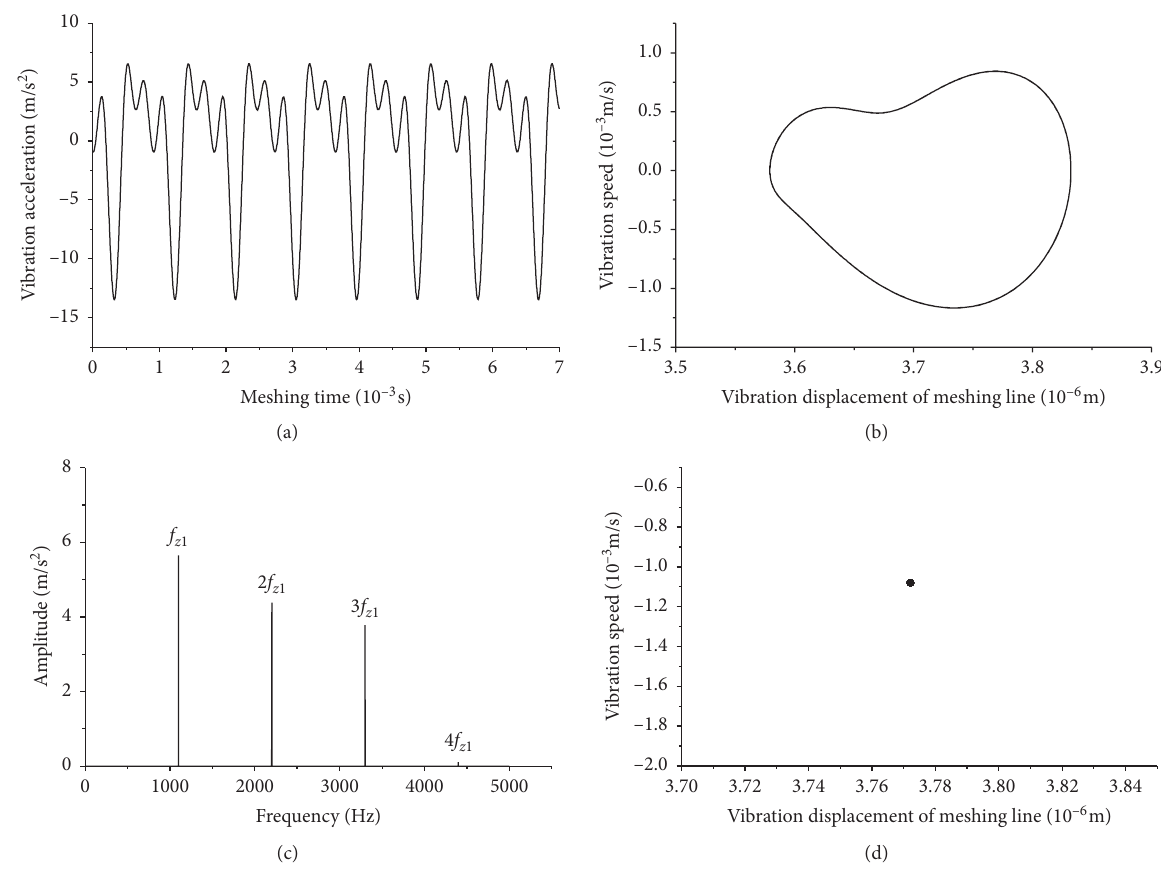
Figure 9: Vibration response of single-stage helical gear transmission system at 3,000rpm: (a) time-domain diagram, (b) phase diagram, (c) frequency-domain diagram, and (d) Poincar´e section.